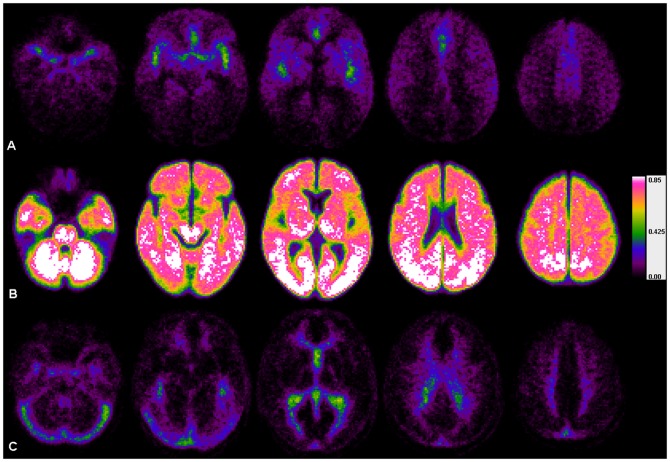
Cumulative vascularity maps (n = 54; TR = 689 ms) of zf-intervals.
Row A: Ιa = {v | −2≤zf(TTPv) <−1}, row B: Ιp = {v |−1≤zf(TTPv) ≤+1} and row C: Ιv = {v |+1 <zf(TTPv) ≤+2}. Using the proposed zf-intervals regions containing mainly arterial vessels (maps in row A), regions containing mainly capillary and small cerebral vessels (maps in row B), and regions mainly containing veins and sinuses (maps in row C), could be easily differentiated. Note, that the interval durations for the different maps were solely derived from the global TTP-distribution, which could be used for individual adjustments of vessel segment specific thresholds. An excellent agreement (shown in green – white colors) between the different exams could be demonstrated, especially for the parenchyma. Anatomical variability between patients, which is expected to be greater concerning the individual shape of the arterial and venous vessel tree, as well as the known technical limitations of echo planar imaging are precluding a 100%-match of the zf-score based compartment-classification in the tested samples.